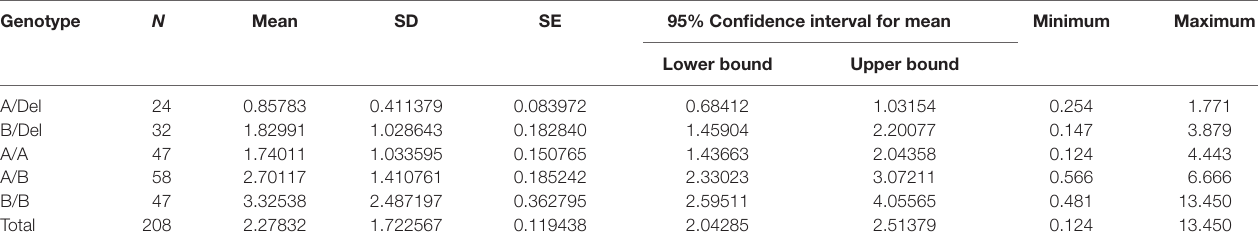
Table 1 | FHR-3 levels differ between CFHR3 genotype groups.